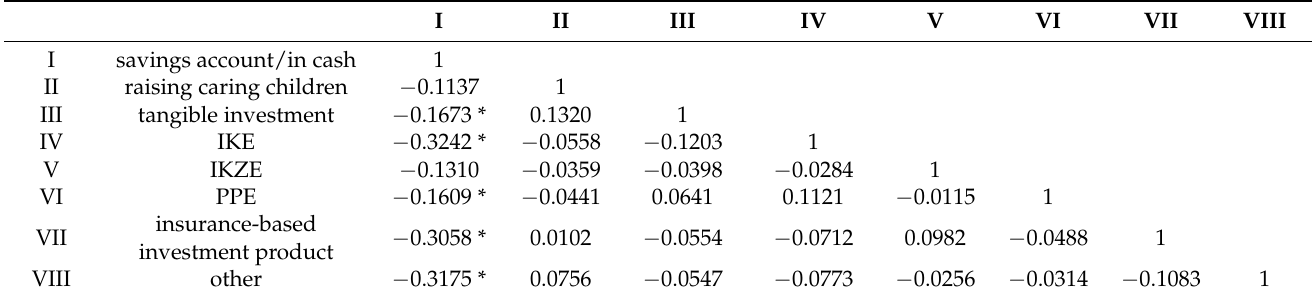
Table 2. Spearman’s correlation of the use of additional saving instruments.